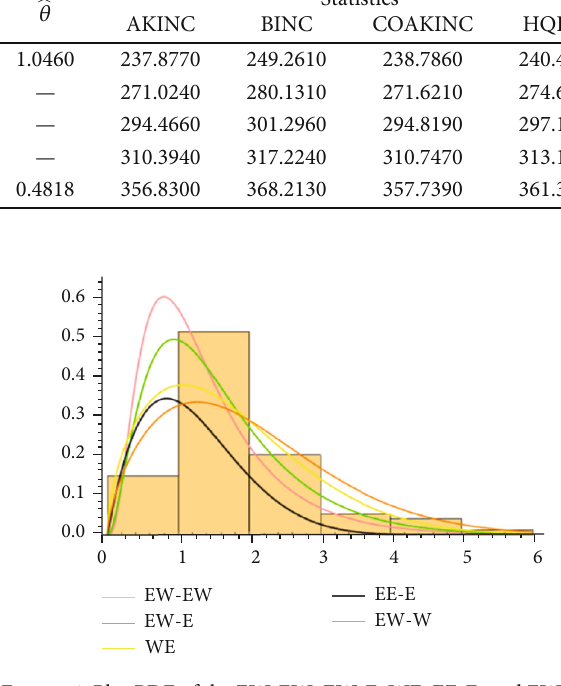
Figure 4: Plot PDF of the EW-EW, EW-E, WE, EE-E, and EW-EW with the empirical distribution for the 1 st